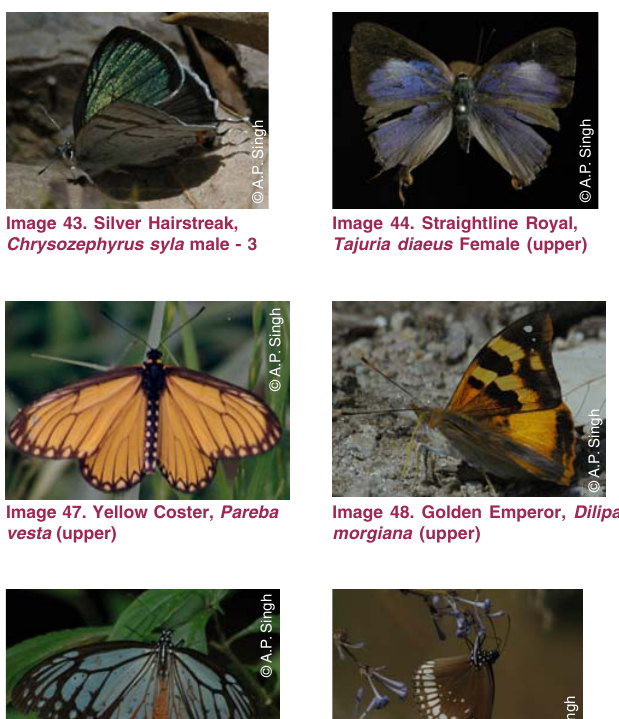
(upper)Image 52. Common Indian Crow, Euploea core